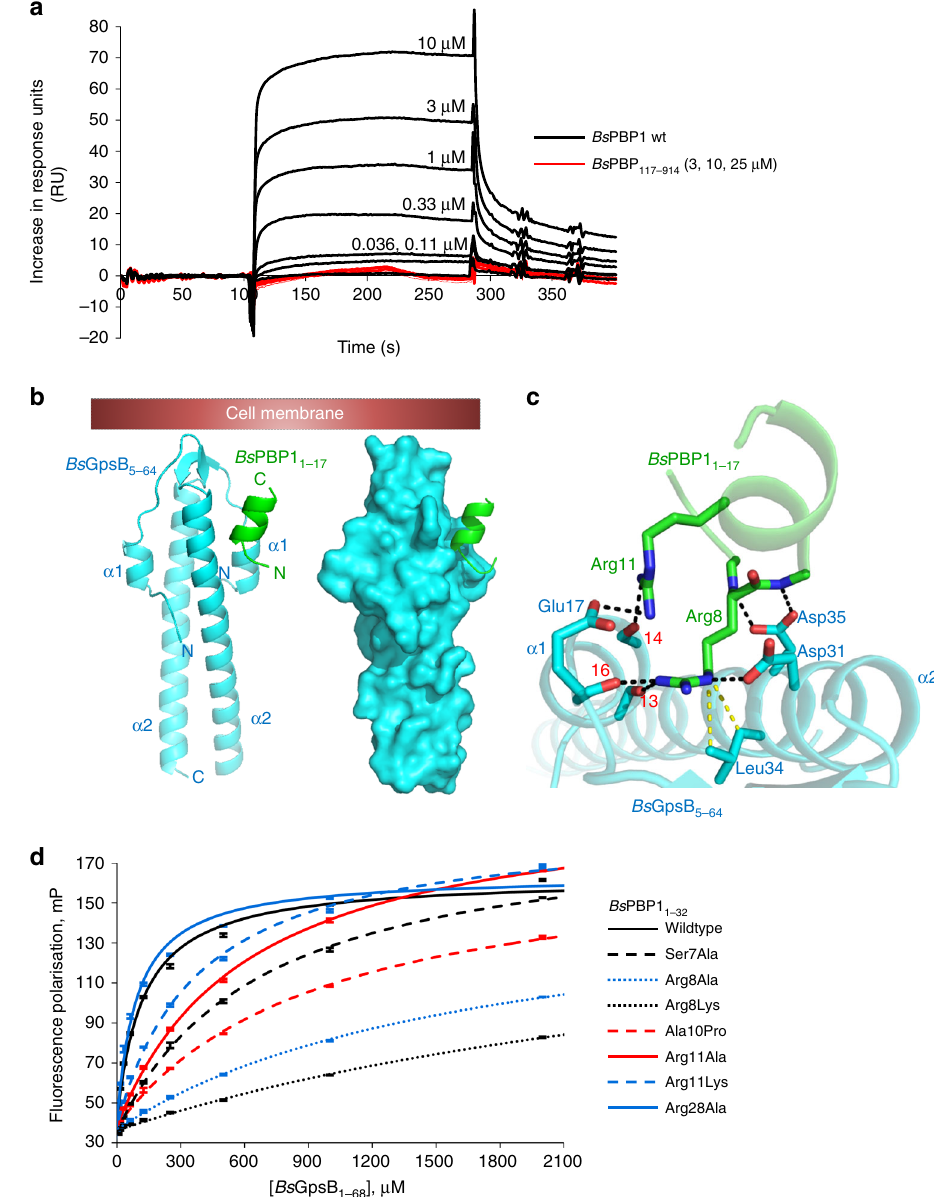
Fig. 1 Bs GpsB: Bs PBP1 interactions require conserved arginines in the α -helical cytoplasmic minidomain of Bs PBP1. a Bs GpsB interacts with the fi rst 16 amino acids of Bs PBP1. SPR sensorgrams of full-length Bs GpsB against immobilised full-length Bs PBP1 (black) and Bs PBP1 17-914 (red). Bs GpsB does not interact